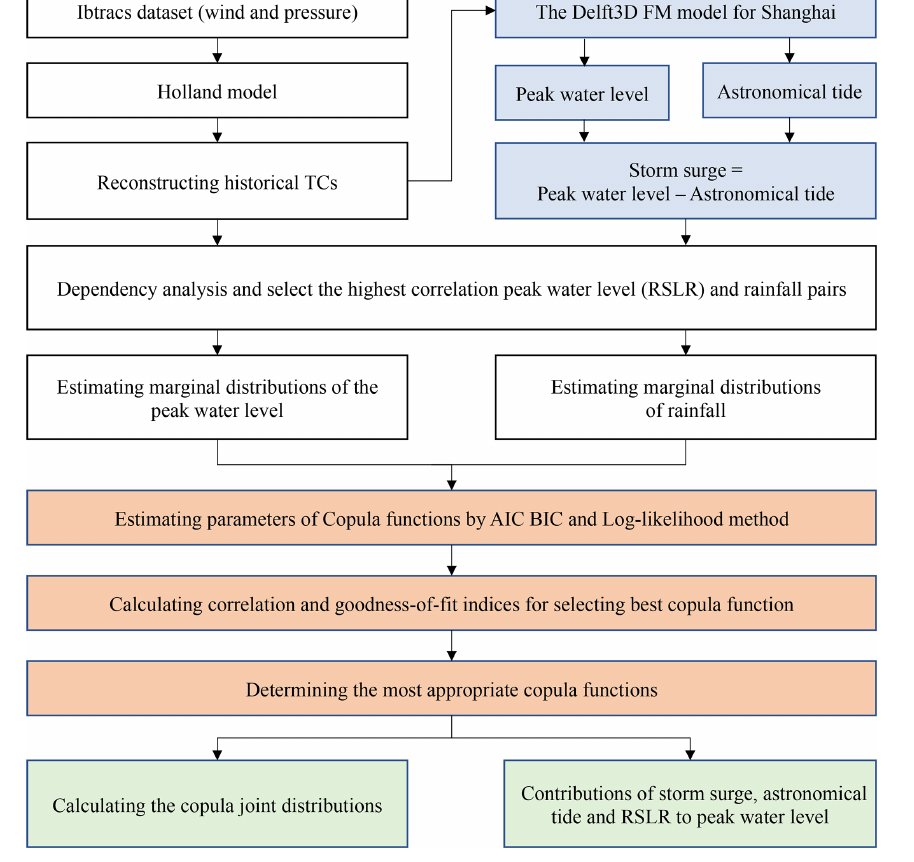
Figure 3. Flowchart of this